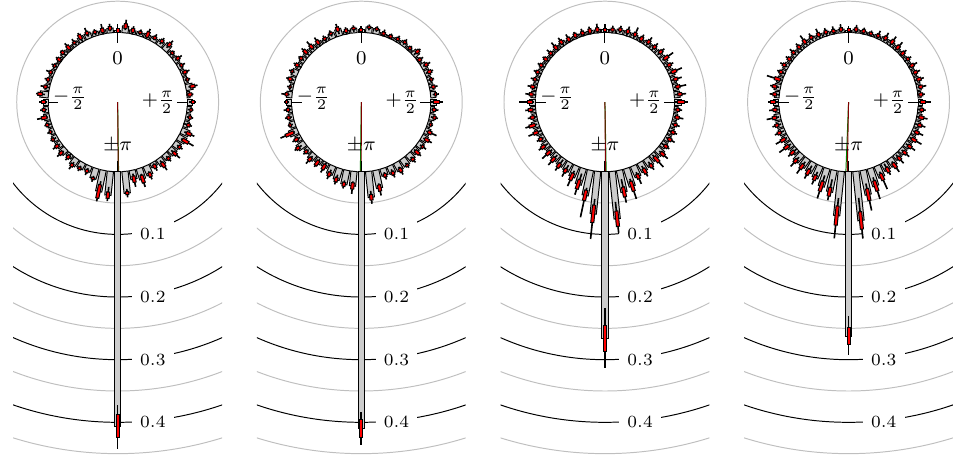
Figure 23. EUR-USD versus USD-CHF (cf. Figure